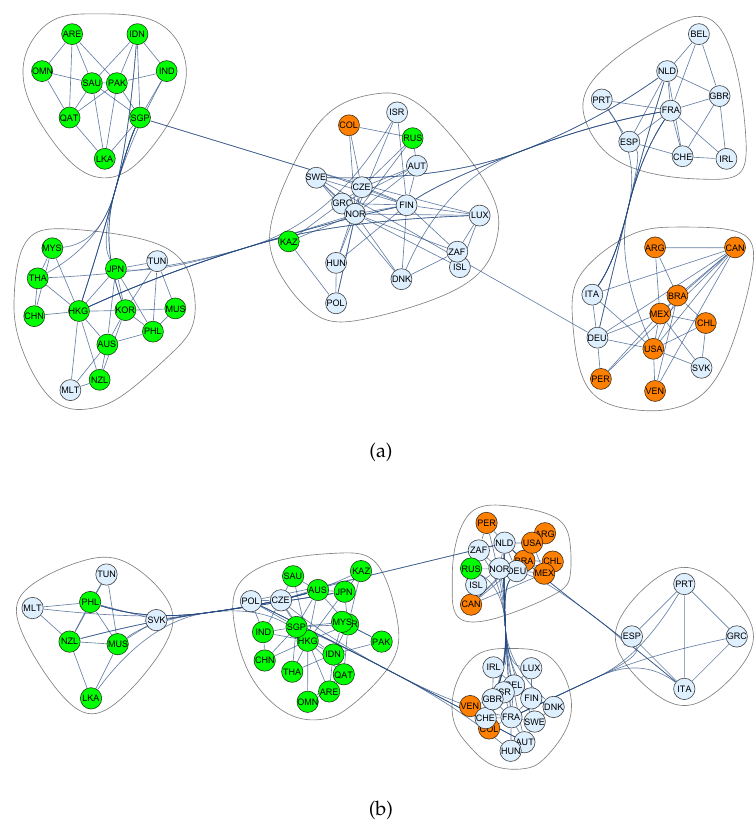
Figure 3. Planar maximally filtered graph (PMFG) for the stock markets obtained using synchronous correlations during ( a ) the economically calm period and ( b ) crisis period. The countries are denoted by their three-letter symbols and are color-coded according to their geographical locations: green for Asia, light blue for Europe and orange for the Americas. During the calm period, we detect five large clusters which are mostly geographically divided. The clusters significantly change during the crisis period. Most notably the troubled Eurozone countries, Italy, Spain, Greece and Portugal, form their own cluster. The Asian countries form one larger cluster centered around Hong Kong and